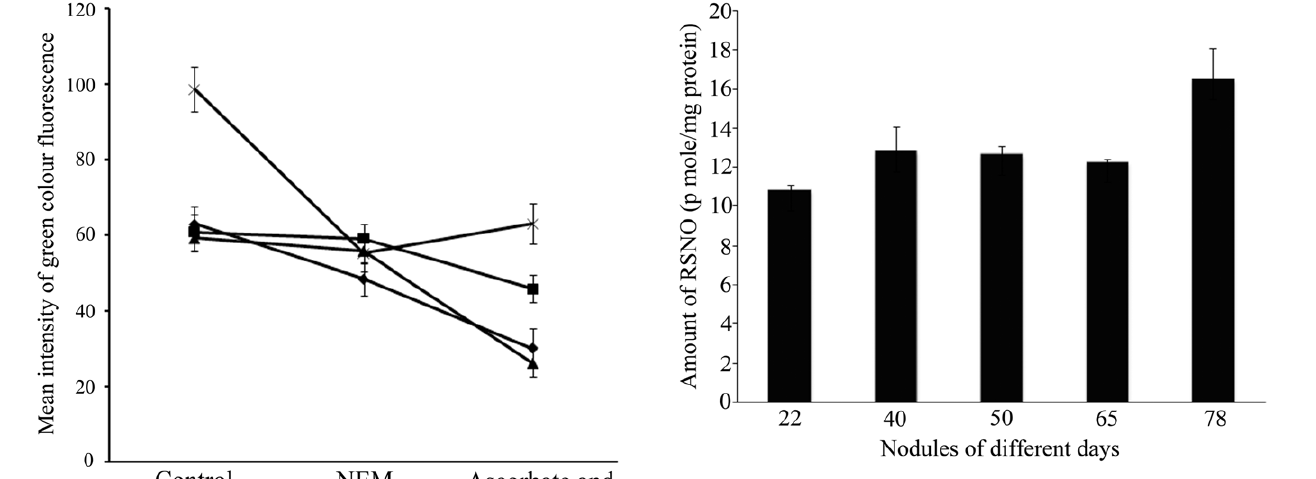
Figure 5. Biochemical quantification of Nitrosothiol by Saville assay. Quantification of nitrosothiol in 22, 40, 50, 65 and 78 day old nodule extracts of A. hypogaea was done by Saville assay. Results were expressed as mean 6 SD, for n=3 experiments. P # 0.01, using one-way ANOVA.